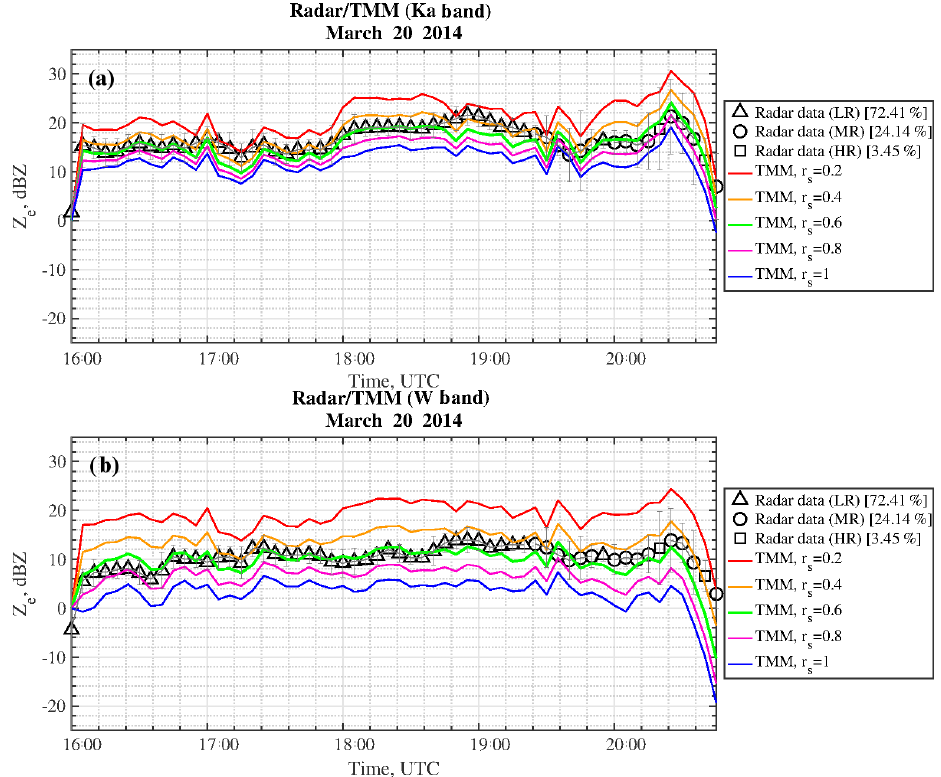
Figure 11. Same as Fig. 8, but for 20 March 2014, 16:00–20:48UTC (LR, MR and HR snowfall in black triangles, circles and squares, respectively). The X-band radar data are not available for this time